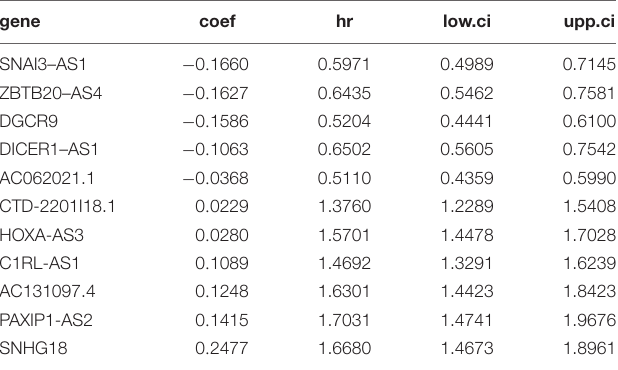
TABLE 1 | Construction of inflammation-related lncRNAs in the risk